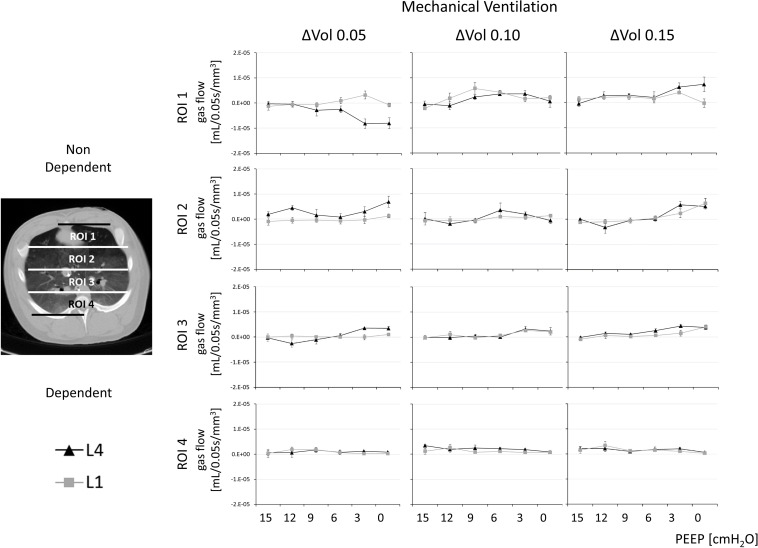
Gas redistribution during the isovolumetric phase of inspiration: the pendelluft analysis. Pendelluft during controlled mechanical ventilation in paralyzed conditions. Complementary information in Figure 2 and Supplementary Figure 1.